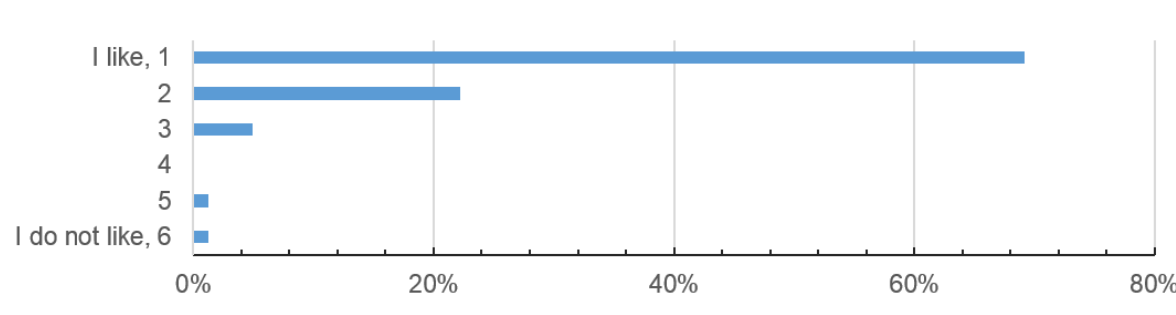
Figure 4. Patient opinion about mobile technologies in medicine (scale from 1 = “I like the development” to 6 = “I don’t like the development”).